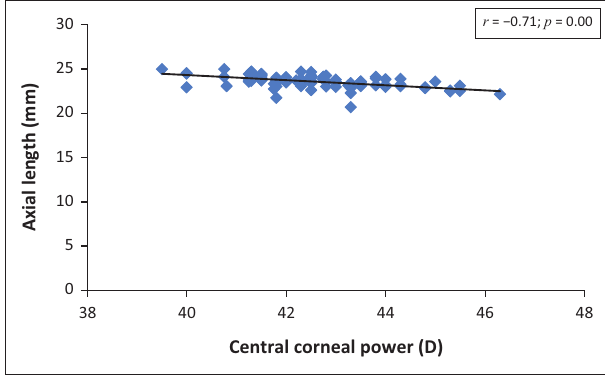
010 FIGURE 1: Histogram presenting the distribution of central corneal power of near-emmetropic (97 men and 103 women) students, aged 18–23 years. TABLE 2: Distribution of central corneal power (CCP) in near-emmetropic students (97 men and 103 women). Ages (years) Males CCP † , CP † (mean ± s.d.) TABLE 3: Distribution of central corneal power (CCP) in near-emmetropic students in the age range of 18–23 years, (mean 20.5 years). Variable 18 years ( n = 19) 20.521.021.522.022.523.023.524.024.525.025.5 FIGURE 2: A significant negative correlation between central corneal power and axial length in male students ( n = 97).